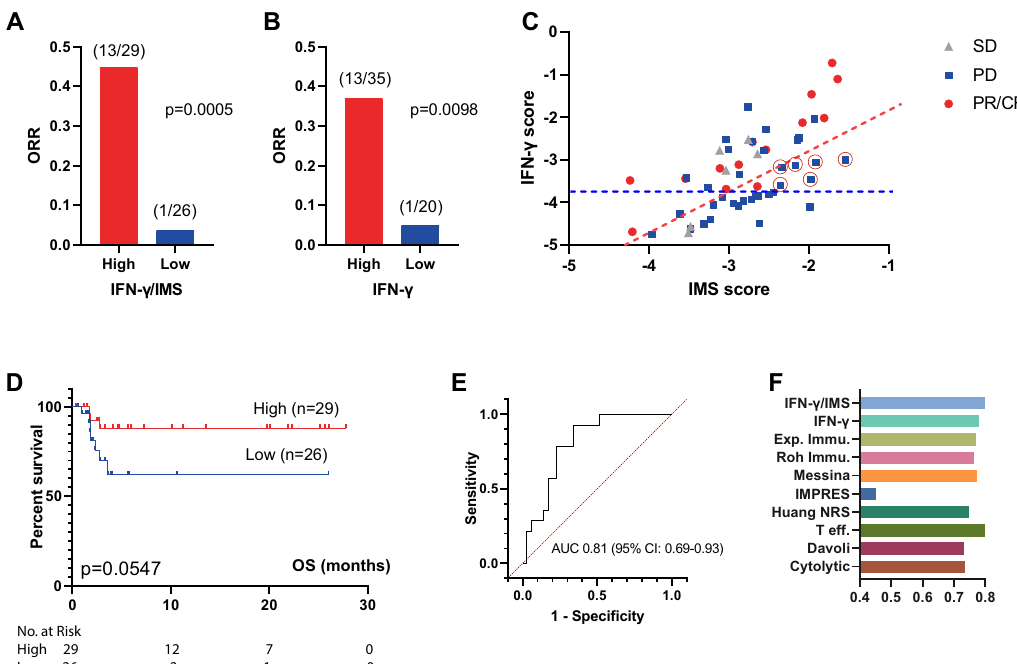
Fig. 5 Ratio of IFN- γ signature to IMS predicts response to ICI immunotherapy on the PUCH cohort. A The ORR of patients from IFN- γ /IMS- high versus IFN- γ /IMS-low and B IFN- γ -high versus IFN- γ -low on the PUCH cohort. The cutoff points were decided by the Youden index for IFN- γ /IMS and IFN- γ scores, respectively. C IFN- γ signature and IMS scores of individual patients in the PUCH cohort. The red and blue dashed lines indicate the cutoff points for IFN- γ /IMS ratio and IFN- γ , respectively. Red circles indicate nonresponse patients who were misclassi fi ed by IFN- γ signature and correctly classi fi ed by IFN- γ /IMS ratio. D Kaplan – Meier plots of OS segregated by IFN- γ /IMS ratio with cutoff points selected according to the Youden index. E ROC curve of the sensitivity versus 1-speci fi city of the predictive performance of IFN- γ /IMS. Patients with SD were not included in AUC calculation. F Comparison of the AUC of IFN- γ /IMS with nine GEP signatures (Table 1) in predicting response to